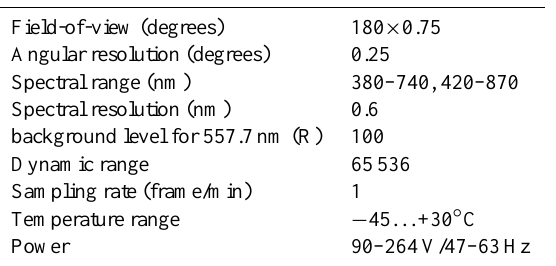
Table 1. Instrumental parameters of the All-Sky CCD Image Spec- trograph S-180.